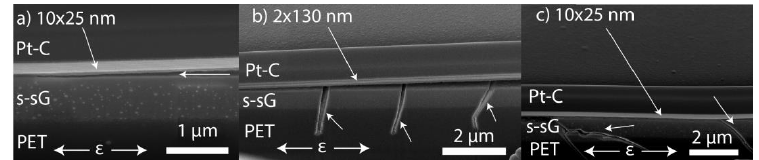
Figure 6. SEM images of FIB cut cross-sections (52° angle) of the indicated samples (s-sG = sub-surface growth, Pt-C = local protection material deposited by FIB for FIB cut) showing additional failure modes (marked by arrows) brought by the subsurface growth. ( a ) Failure of the sub-surface growth material that delaminates the film ( b ) crack failure of the sub-surface growth material that propagates to the PET substrate, ( c ) failure of the sub-surface growth material that partially delaminates the film.